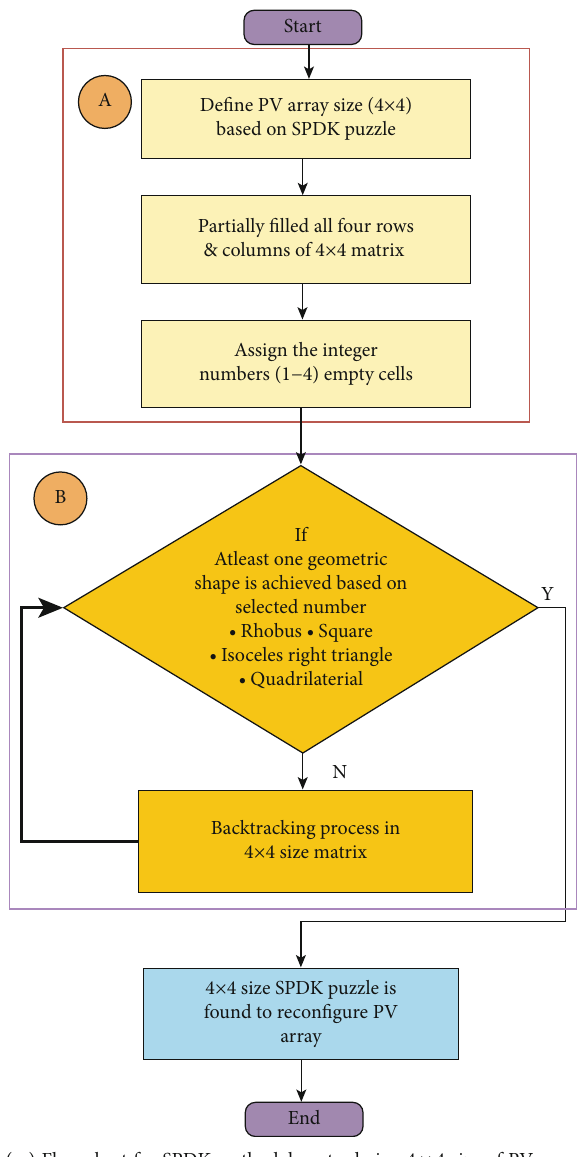
Figure 12: (a – m) Con fi gurations and fl ow charts for conventional, hybrid, game puzzle-based SPV arrays [85 –